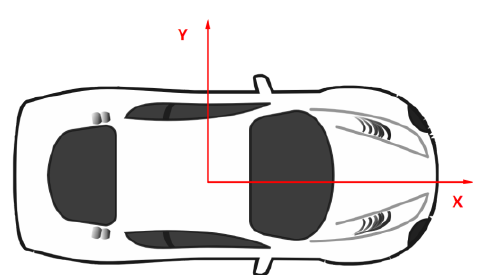
Figure 4. Two definitions of misalignments in electric vehicles (EV): X-misalignment is the front-to-rear misalignment and Y-misalignment is the door-to-door misalignment [2 5 ].